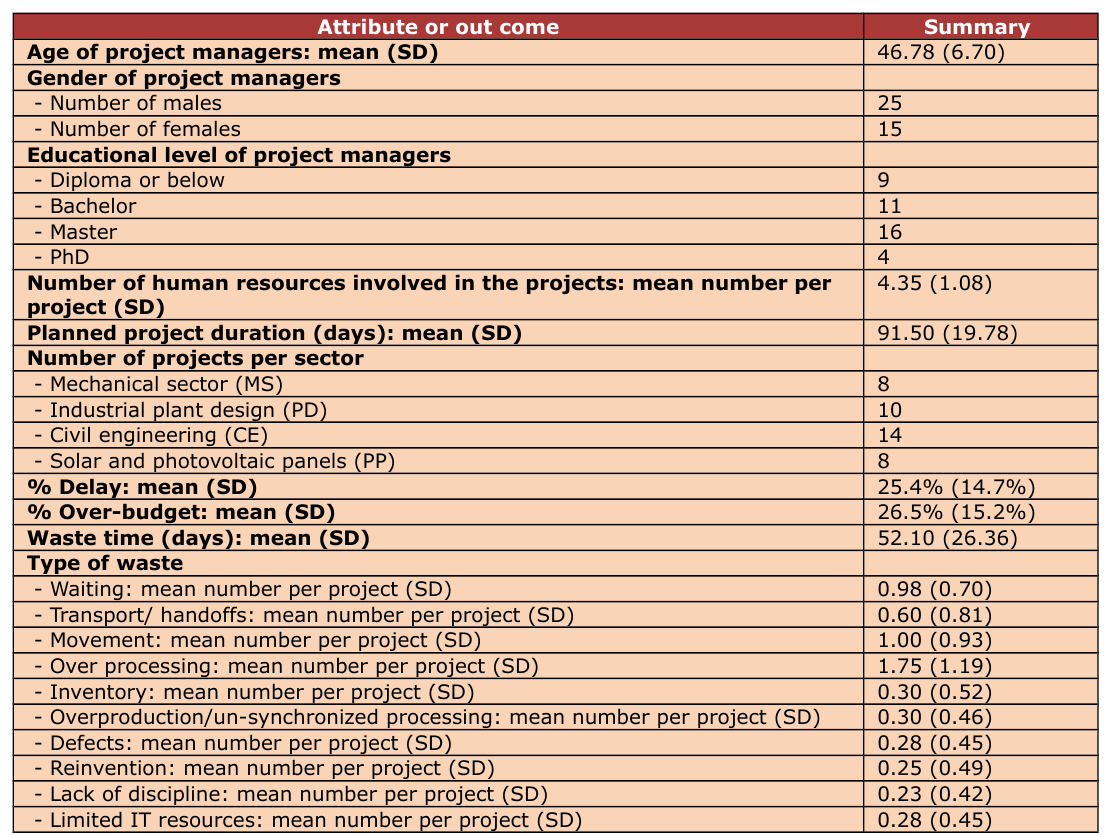
Table 2. Project characteristics and summary performance